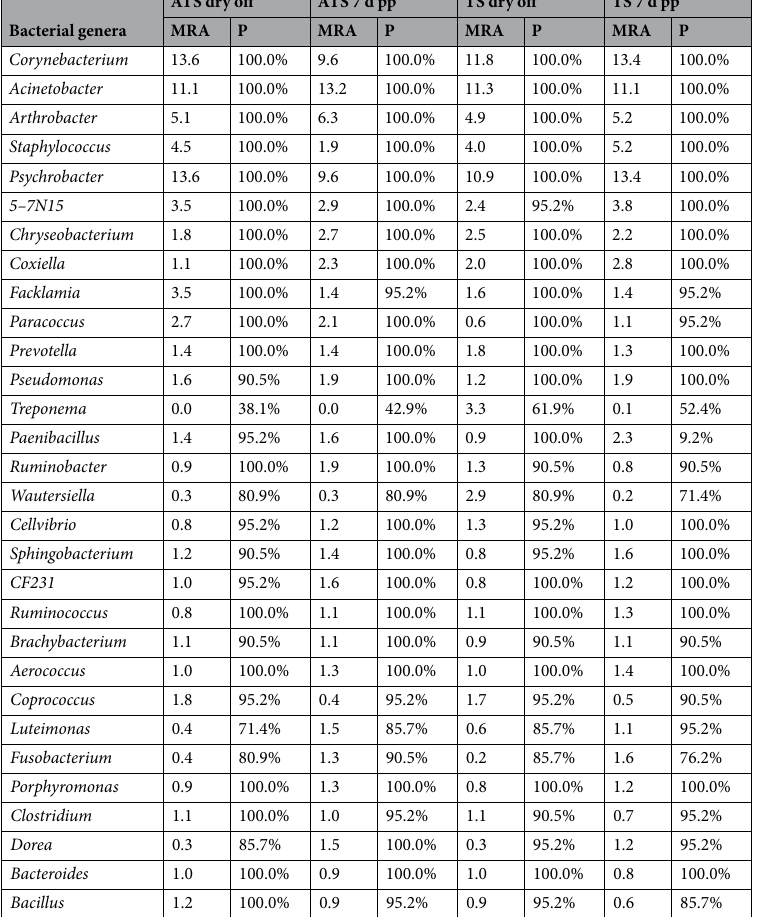
Table 2. Descriptive statistics of the 30 most abundant bacterial genera. 1 MRA = Mean relative abundance of bacterial genera at dry off and 7 days postpartum for cows receiving antibiotic (ceftiofur hydrochloride) and teat sealant (ATS) or just teat sealant (TS). 2 P = Percentage of study milk samples in which the indicated genus was detected at the given sample. pp =